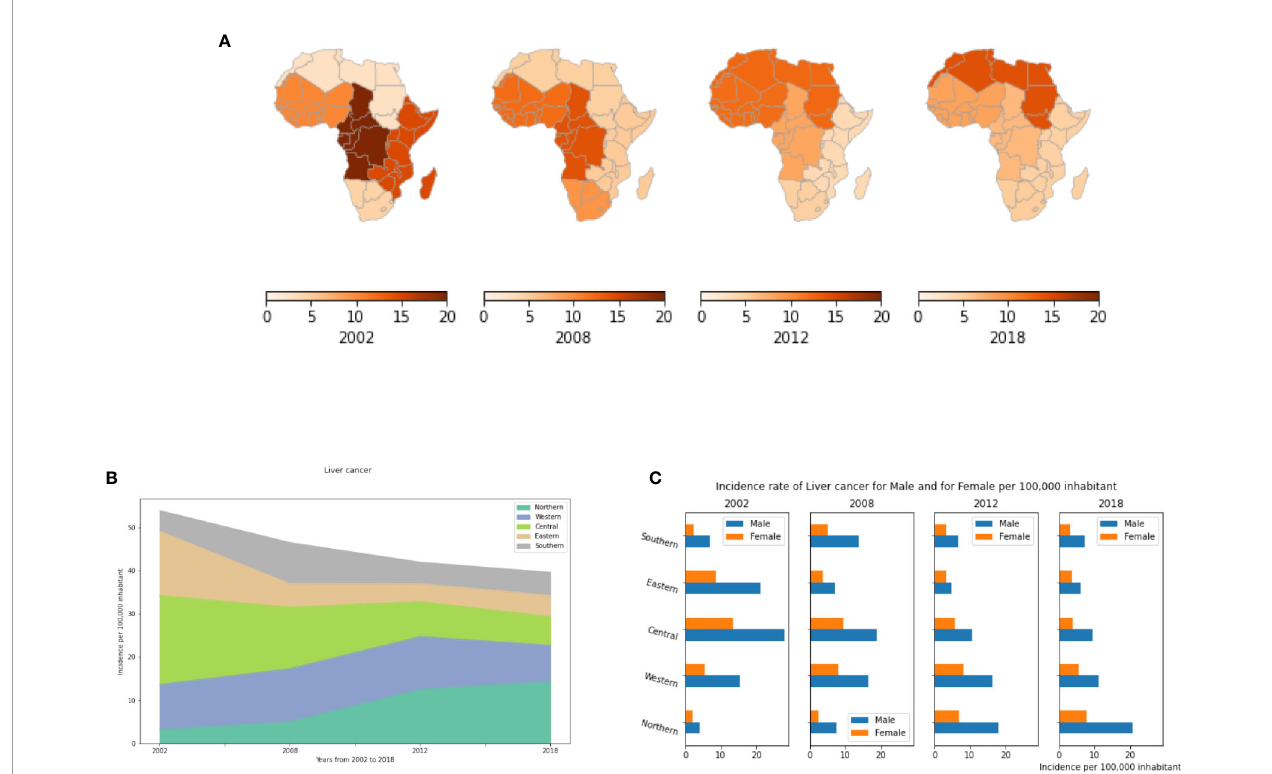
FIGURE 8 | Liver cancer incidence rates by year, by African region and by gender. (A) Liver cancer incidence rate per 100,000 inhabitant in different African regions. (B) Dynamics of the incidence from 2002 to 2018. (C) Liver cancer incidence by